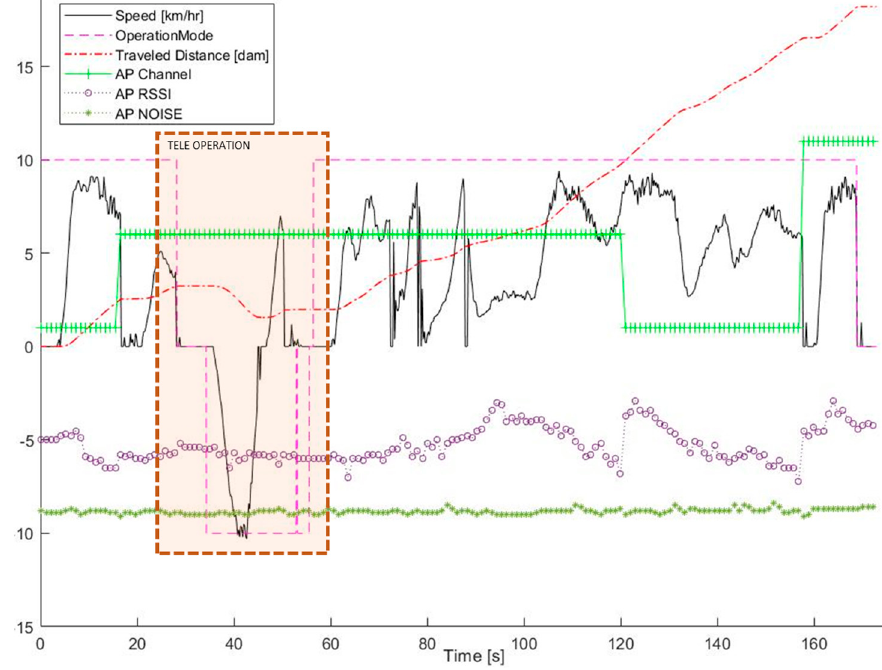
Figure 16. Instant speed, operation mode, distance traveled, and wireless communication channel